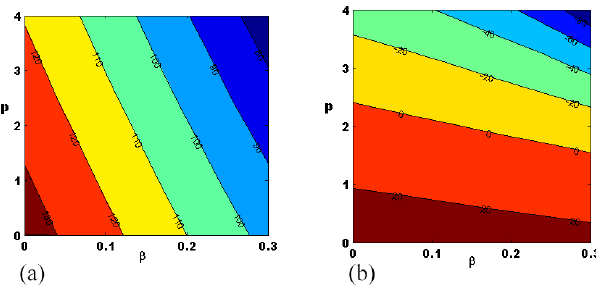
gated by means of contour plots. These plots indicate the sensitivity of the buckling loads to problem parameters and it was observed that buckling load under concentrated tip load is more sensitive to the change in the cross-section. On the other hand buckling load is more sensitive to the magnitude of the tip load for the clamped-free boundary conditions.